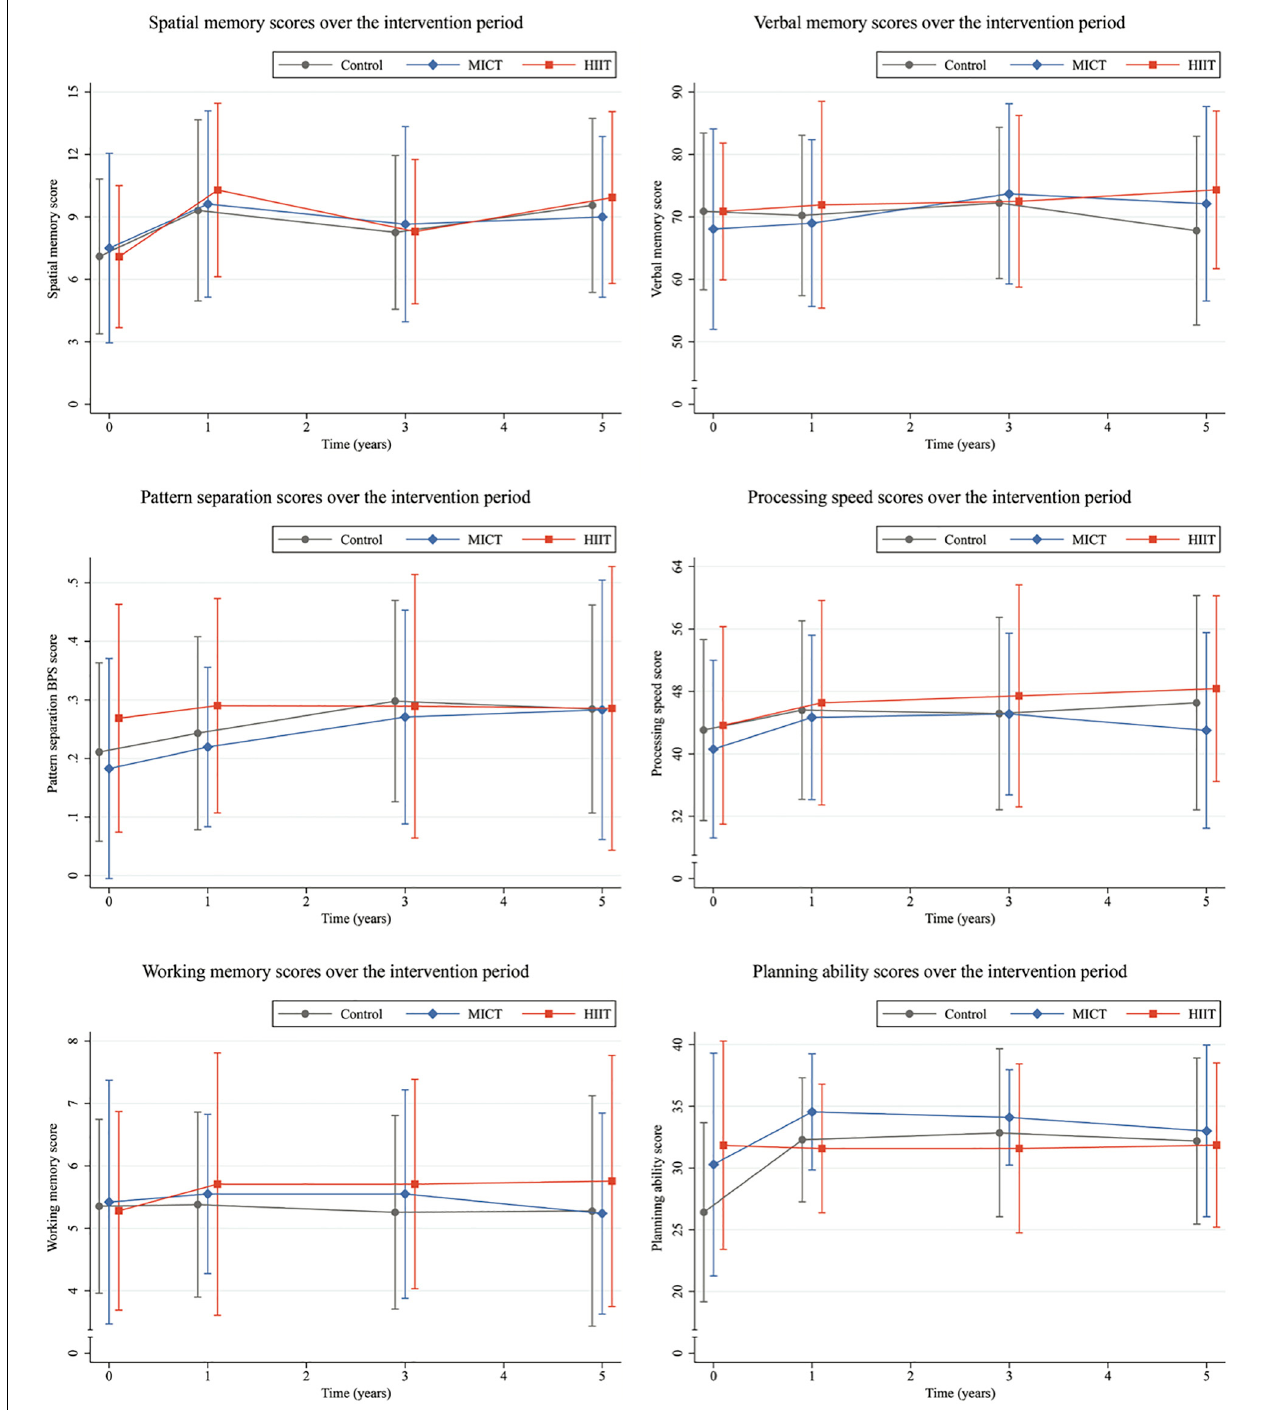
FIGURE 3 | Performance of the Control (gray), moderate-intensity continuous training (MICT, blue), and high-intensity interval training (HIIT, orange) groups on the cognitive tests over time. Whiskers represent one standard deviation below and above the group mean.